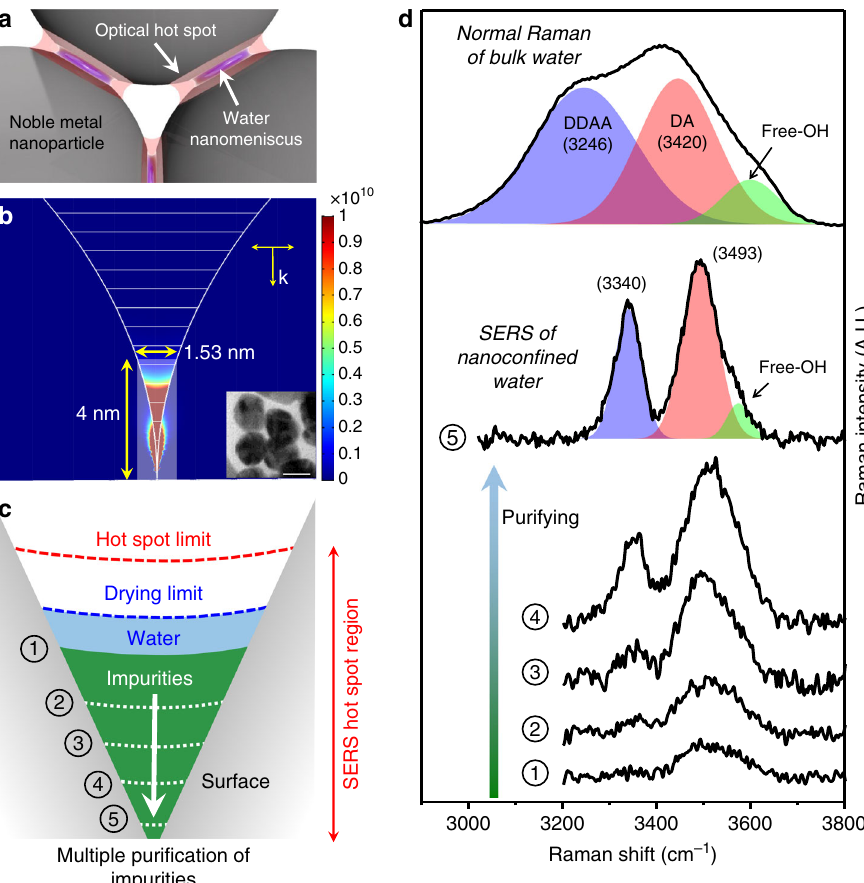
Fig. 1 SERS for trace amounts of ultra-puri fi ed nanocon fi ned water. a Schematic showing the trapped water nanomeniscus in the optical hot-spot region after the highly puri fi ed silver nanoparticles (with the surface capped-citrate removed) are dried in ambient conditions. b Finite element method-based simulation of the electromagnetic fi elds shows that the fi eld-enhanced region (or the SERS hot-spot) is highly localized at the crevice of silver dimer where nanocon fi ned water is formed. Here, the vertical scale represents the electromagnetic fi eld enhancement ( = |scattered fi eld/incident fi eld| 4 ). Inset shows the transmission electron micrograph (20 nm scale bar). c Schematic of the SERS hot-spot obtained by progressive puri fi cation. The hot-spot limit denotes the maximum optical region where most Raman signal comes from, while the drying limit indicates the maximum spatial region where nanocon fi ned water forms after drying. Stage 1 corresponds to the condition where most water is excluded from the hot spot due to the unremoved impurities remaining at the crevice, while stage 5 presents the situation where water occupies mostly the hot spot. d Spectra (1 – 5) show the increasingly prominent SERS signal of nanocon fi ned water as puri fi cation progresses, in contrast to the normal Raman of the bulk water (black curve, top) that shows three OH-stretching bands for the hydrogen bonding (HB) con fi guration; DDAA (D: HB donor, A: HB acceptor), DA and free-OH (for simplicity, negligible effects of DAA and DDA bands are